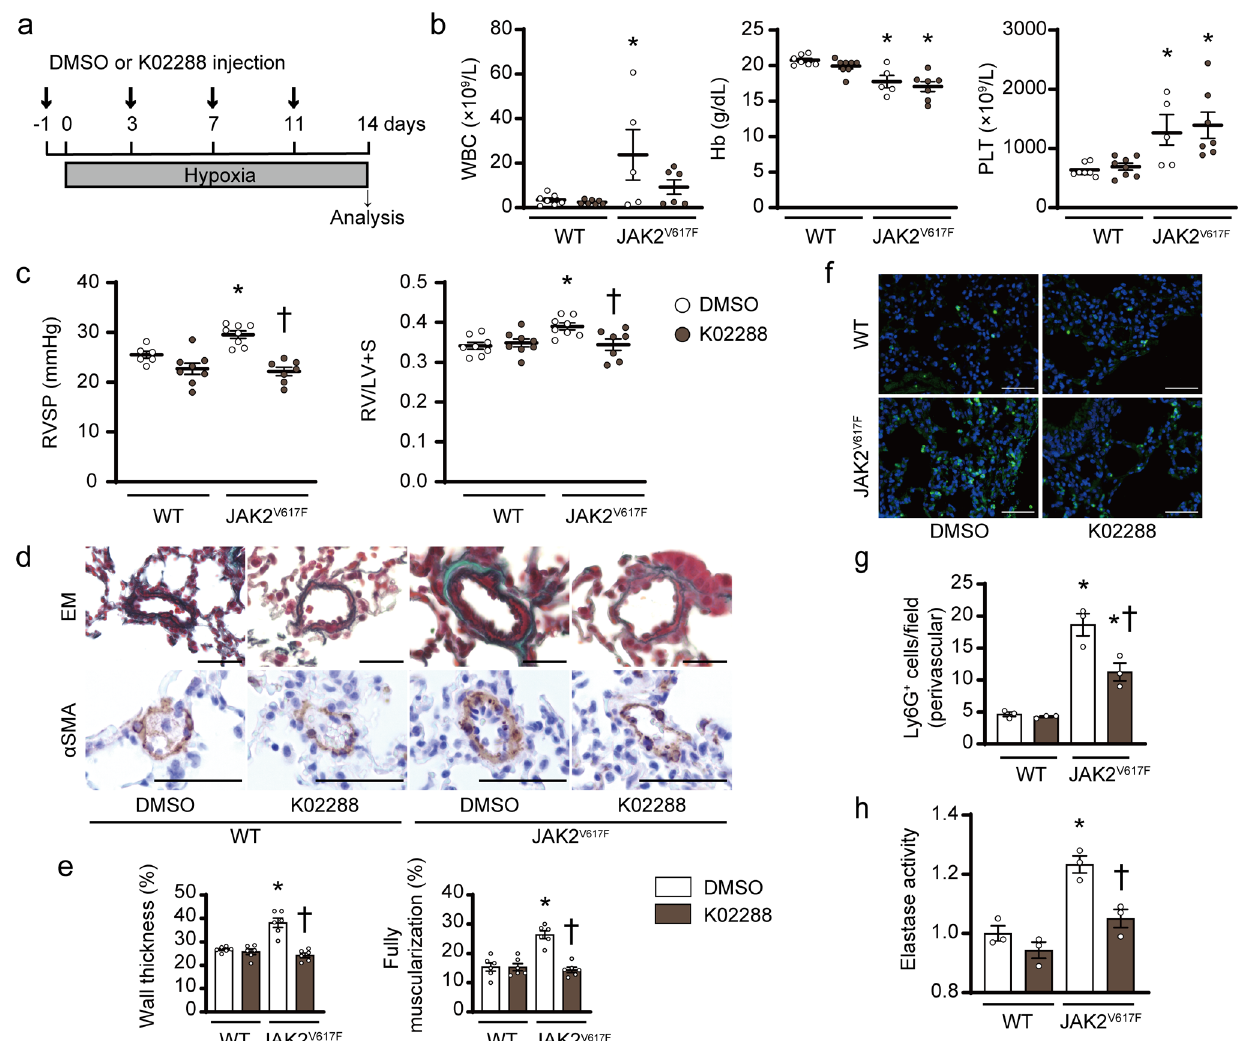
Fig. 8 Inhibition of ALK1/2 improves chronic hypoxia-induced pulmonary hypertension in JAK2 V617F mice. a Schematic protocol. Vehicle (DMSO) or an ALK1/2 inhibitor, K02288 was administered via an intraperitoneal injection of 12 mg/kg body weight during 2-week chronic hypoxia-exposure, as indicated. b Peripheral blood cell counts in DMSO- or K02288-treated WT mice and JAK2 V617F mice after exposure to chronic hypoxia for 2 weeks ( n = 7, 7, 5, 6, * P = 0.0381 for WBC, n = 7, 8, 5, 7, * P = 0.0074 [left], 0.0037 [right] for Hb, n = 7, 8, 5, 7, * P = 0.0401 [left], 0.0120 [right] for PLT). c RVSP and RV hypertrophy determined by RV/LV + S in DMSO- or K02288-treated WT mice and JAK2 V617F mice ( n = 6, 8, 8, 7, * P = 0.0238 for RVSP, n = 8, 8, 8, 7, * P = 0.0112, † P = 0.0240 for RV/LV + S). d Representative images of EM-stained sections and sections immunostained with anti- α SMA antibody from DMSO- or K02288-treated WT mice and JAK2 V617F mice. Scale bar, 25 µ m. e Quantitative analysis of medial wall thickness in EM-stained sections (left, n = 6 in each group, * P < 0.0001, † P < 0.0001) and the percentage of muscularized distal pulmonary vessels in α SMA-immunostained sections (right, n = 6 in each group, * P < 0.0001, † P < 0.0001). f Representative immuno fl uorescence images of lung sections stained with anti-Ly6G (green) antibody and DAPI (blue). Scale bars, 50 μ m. g Quantitative analysis of the numbers of Ly6G + cells in the perivascular regions ( n = 3 in each group, * P = 0.0001 [left], 0.0103 [right], † P = 0.0074). h Elastase activity in the lung extracts from DMSO- or K02288-treated WT mice and JAK2 V617F mice. The average value for DMSO- treated WT mice was set to 1 ( n = 3 in each group, * P = 0.0017, † P = 0.0075). All data are presented as mean ± SEM. * P < 0.05 versus the corresponding WT mice and † P < 0.05 versus DMSO-treated JAK2 V617F mice by the one-way ANOVA with Tukey post-hoc analysis. WBC white blood cell count,